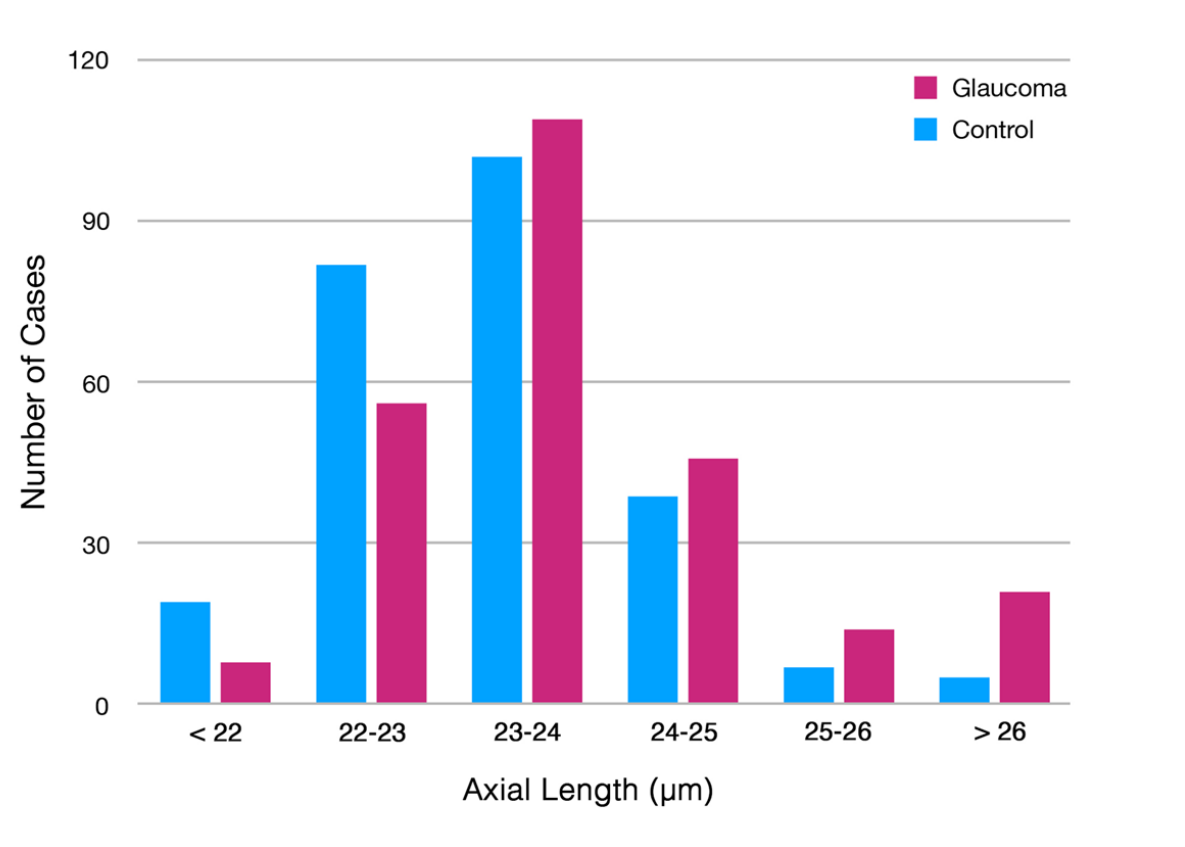
Figure 2. Distribution of axial length of the glaucomatous eyes and control eyes in the validation